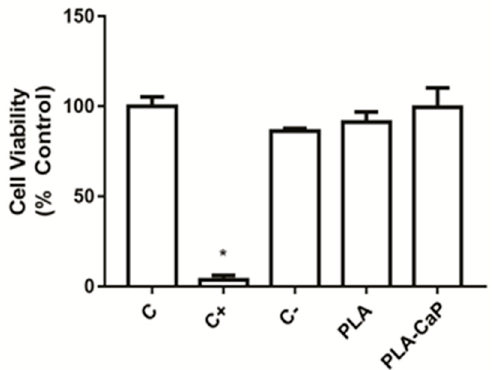
Figure 6. Cytocompatibility evaluation of the scaffolds, as evaluated by XTT assay. Bars indicate mean ± SD results normalized as a percentage of the unexposed control group (C). Extracts of polystyrene beads were used as negative control (C − ) and fragments of latex as a positive control (C+). An asterisk indicates a significant difference with all other groups ( p < 0.05).